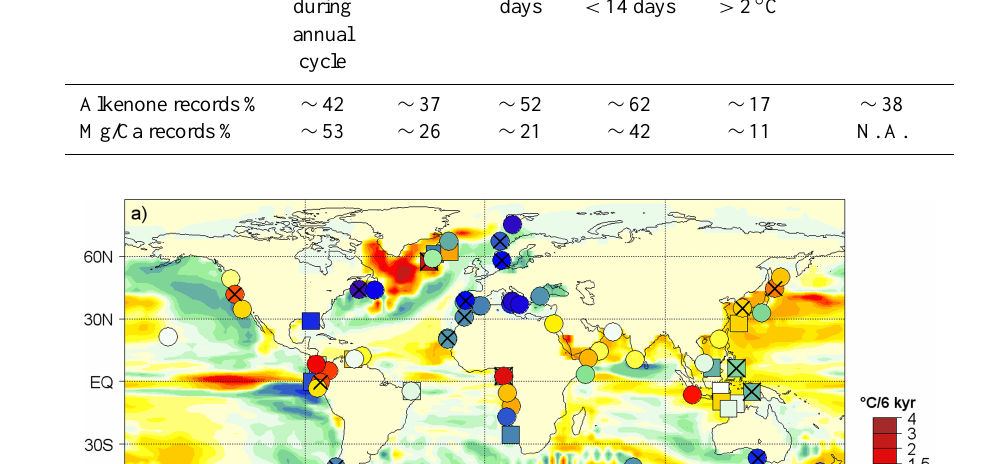
Table 5. Overview on the agreement between model and proxy data. We list cores that agree with the model simulation at some time during the year and summarize the number of cores that could be reconciled with the model simulation by assumed shifts of < 20m of the habitat depth and < 14 days of the blooming season. We also list cores that show a difference of more than 2 ◦ C to the model simulation, and note cores that might be biased by calibration uncertainties.